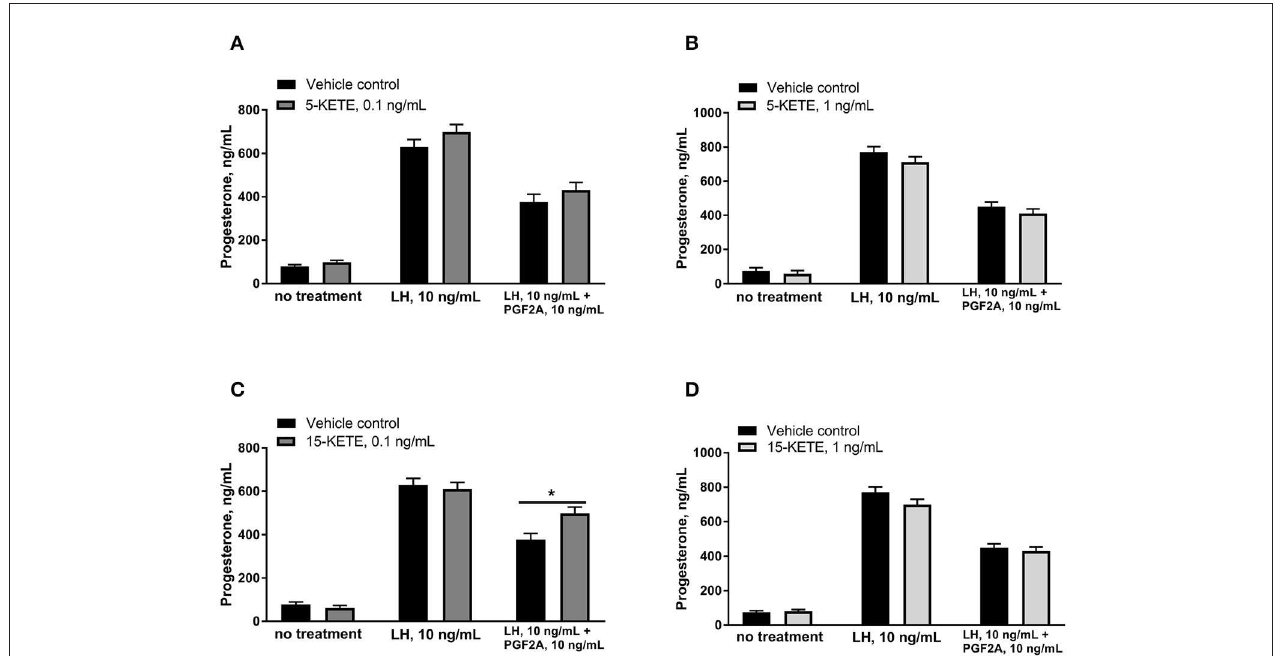
FIGURE 9 | Effect of 0.1ng/mL (A) and 1ng/mL (B) 5-KETE and of 0.1ng/mL (C) and 1ng/mL (D) 15-KETE on progesterone production in cultured luteal cells on day 7 of culture. Significant differences ( P < 0.05) between lipid-treated and vehicle control are denoted with a * ( N = 4). Progesterone increased abundance of FAAH in T